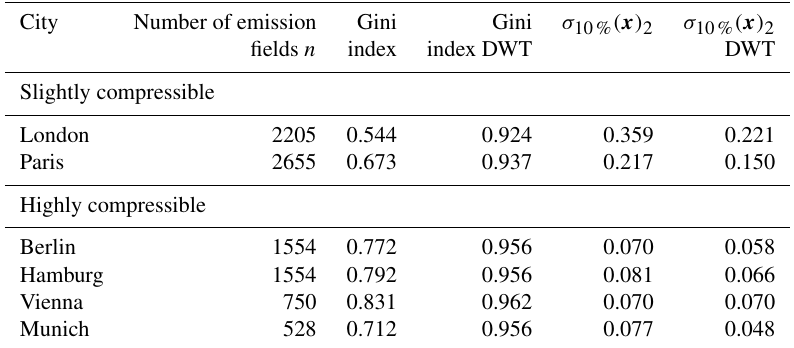
Table 2. Sparsity of the reported emission fields in different European cities. In the wavelet domain, in all of the cases a better or at least as good a sparse approximation of the emission map